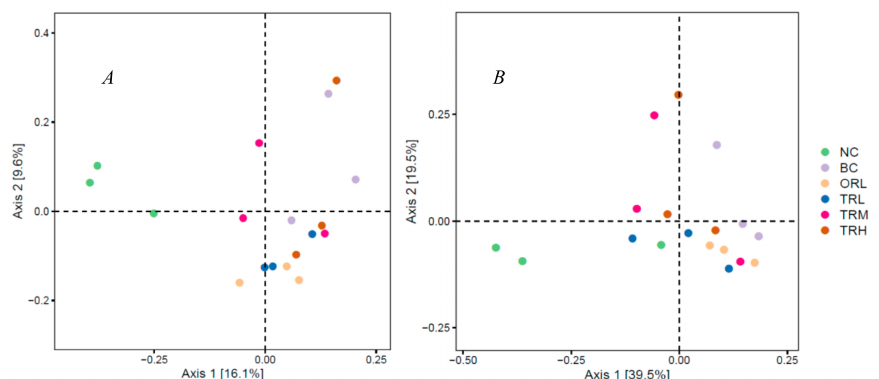
Figure 2. Principal coordinate analysis (PCoA) illustrating the different tested groups of NC, BC, ORL, TRL, TRM, and TRH based on unweighted ( A ) and weighted ( B ) UniFrac distances. PERMANOVAs were accessed by the Adonis method and weighted or unweighted UniFrac distance matrices to analyze significant differences in the gut microbiota composition. NC: Normal control group, chow diet; BC: Blank control group, high-fat diet; ORL: Positive control group, orlistat; TRL: Low-dose group, trilobatin; TRM: Middle-dose group, trilobatin; TRH: High-dose group, trilobatin.